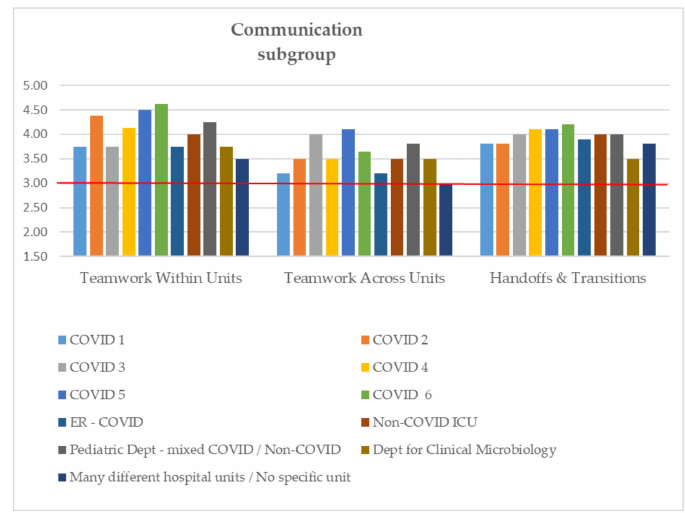
Figure 3. PSC dimension values for the “Communication” group across